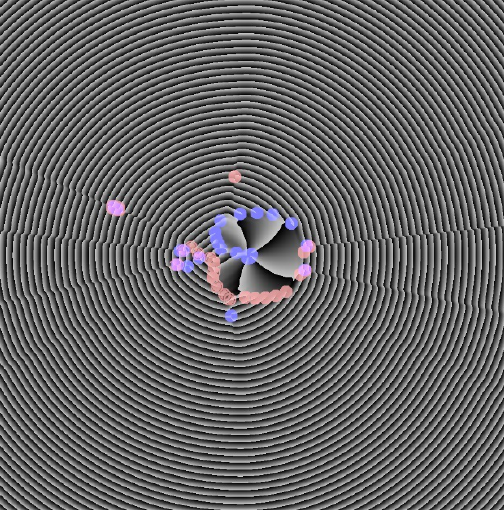
Figure 5. Phase of a light field complex conjugated with field (14) after passing through aperture (15) with the angle α = 150° at a distance of z = λ behind the aperture. Positive dislocations are purple shaded circles and negative ones are within cyan shaded circles. The field size is 48 × 48 μ m.